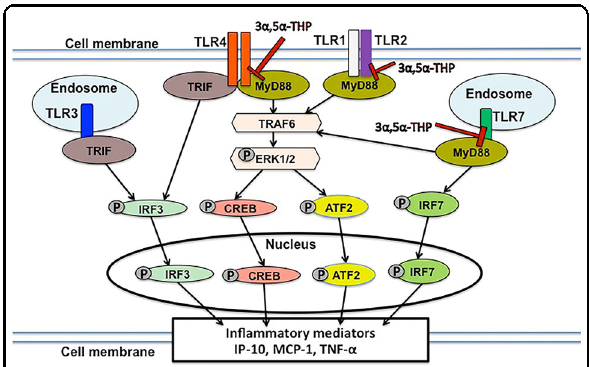
Fig. 4 Schematic of TLR signal inhibition by 3 α ,5 α -THP. TLR4, TLR2, and TLR7 signal activation initiates with TLR binding of MyD88, and this binding is inhibited by 3 α ,5 α -THP. This results in the inhibition of pathway activation, including TRAF6 and activated (phosphorylated) downstream members (pERK1/2, pCREB, pATF2, and pIRF7). The activated transcription factors translocate to the nucleus and initiate the production of various in fl ammatory mediators (IP-10, MCP-1, and TNF- α ). TLR4 also binds TRIF, which is the only adaptor protein bound by TLR3, leading to the phosphorylation (activation) of IRF3. Signi fi cantly, 3 α ,5 α -THP does not inhibit TRIF binding and its resulting signal